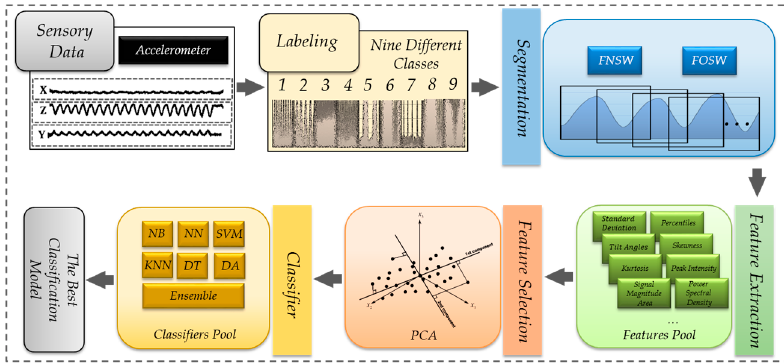
Figure 1. Sensor-based activity recognition procedure.